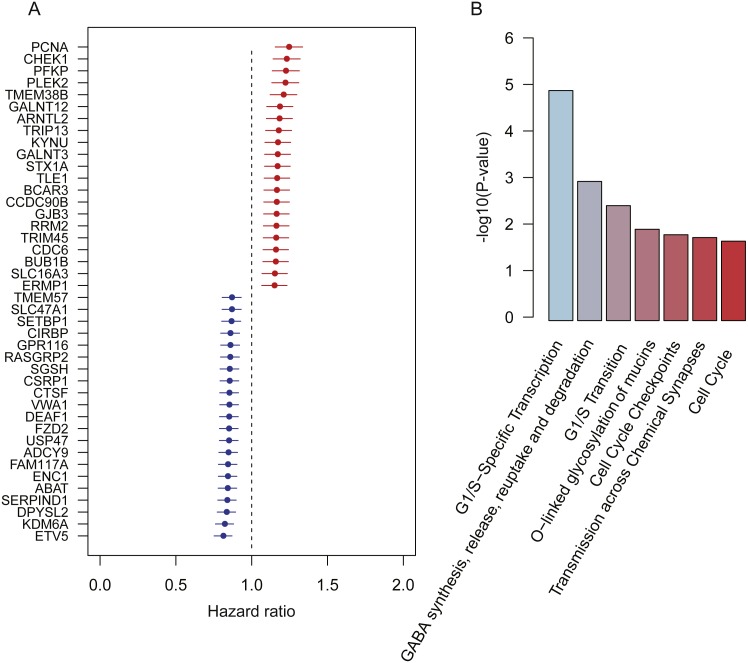
Prognostic genes identified by meta-analysis-based Cox regression analysis.(A) 42 prognostic genes are ordered by hazard ratio. (B) The significance (−log10 (p-value)) of seven pathways enriched by the 42 prognostic genes are represented by the bars.